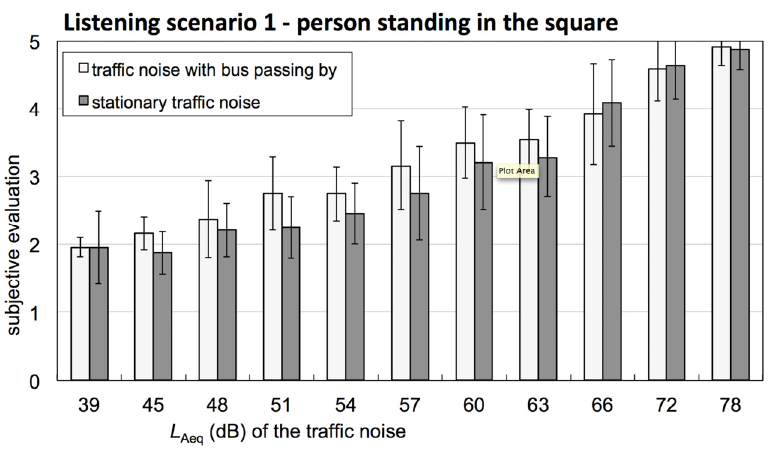
Figure 6. Listening scenario 1: Results given as average values + standard deviation. The 4—noisy or